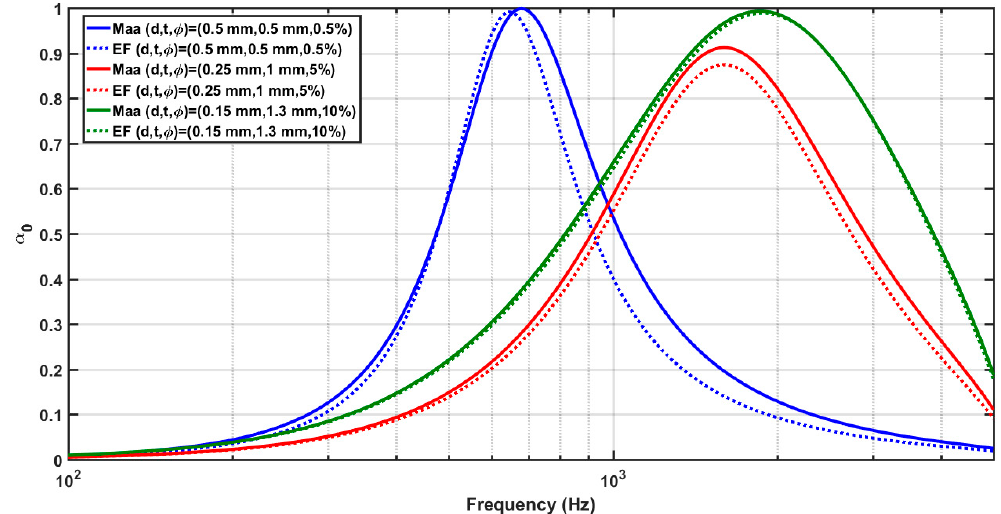
Figure 13. Absorption curves provided by the Maa (solid line) and EF (dotted line) models for D = 3 cm and different combinations of the parameters ( d , t , φ ,).